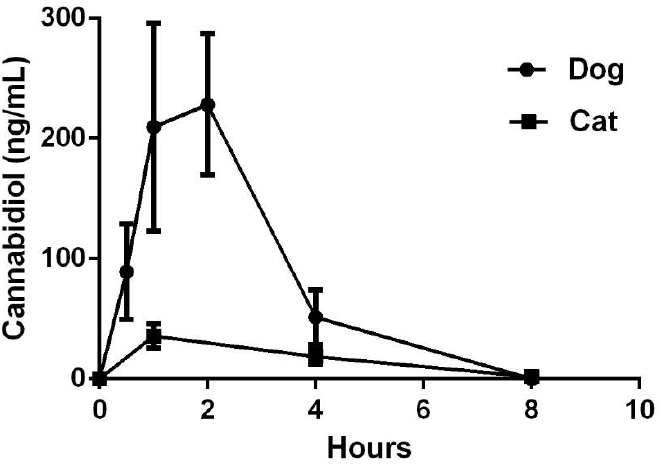
Figure 1. Mean and standard error of the mean (SEM) cannabidiol concentrations from dogs ( n = 5) and cats ( n = 6) at different time points after dosing.